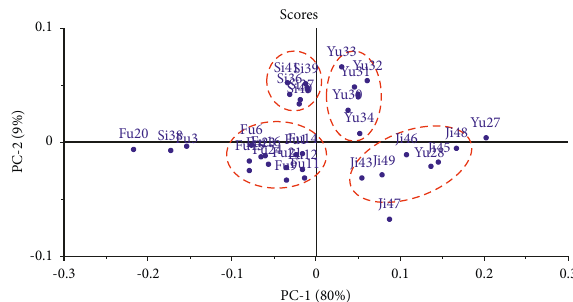
Figure 1: PCA result of T . fuciformis from different